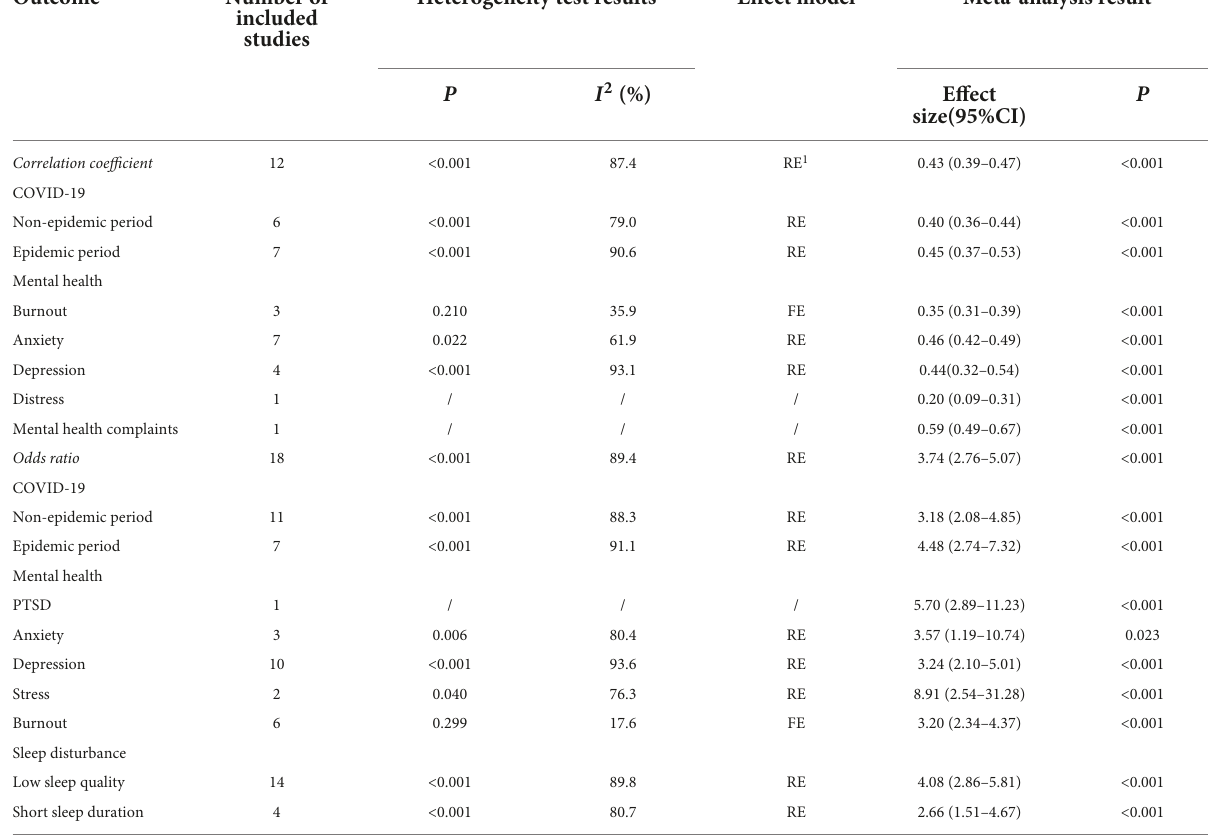
TABLE 3 Subgroup analysis results of the association between sleep disturbance and mental health. Outcome Number of Heterogeneity test included studies